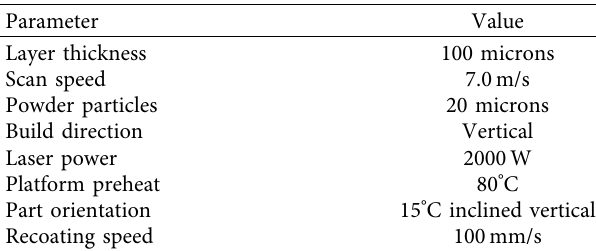
Figure 1: (a) Build orientation of DMLS component with sample for milling experiment and (b) M 280 Direct Metal Laser Sintering RP machine. Table 1: Parameters for fabricating Inconel 718